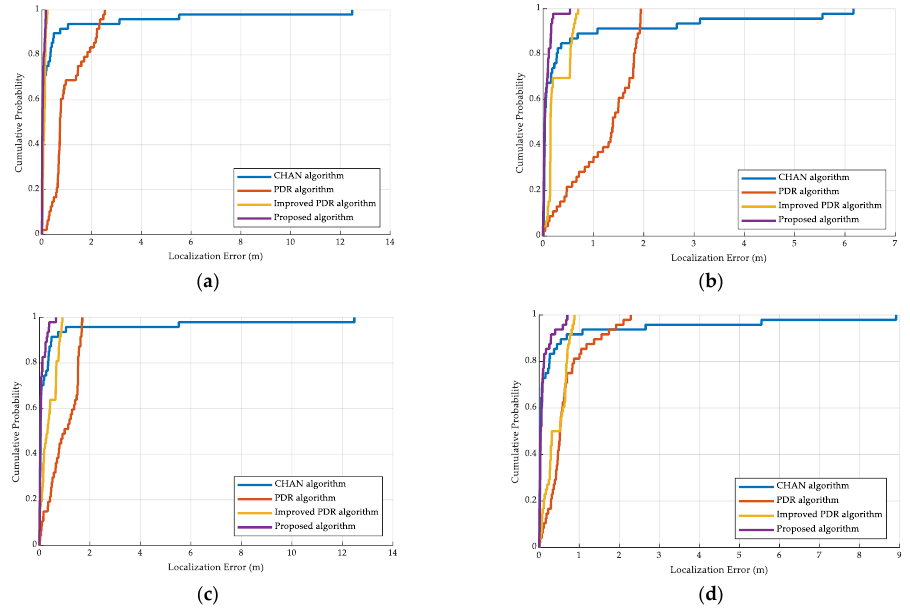
Figure 17. The CDFs of the localization errors among the CHAN algorithm, PDR algorithm, improved PDR algorithm, and the proposed algorithm in the first scene. ( a ) Volunteer #1 with a VivoY85a cell phone (scene 1). ( b ) Volunteer #2 with a VivoY85a cell phone (scene 1). ( c ) Volunteer #1 with an Honor60 cell phone (scene 1). ( d ) Volunteer #1 with an Honor60 cell phone (scene 1).